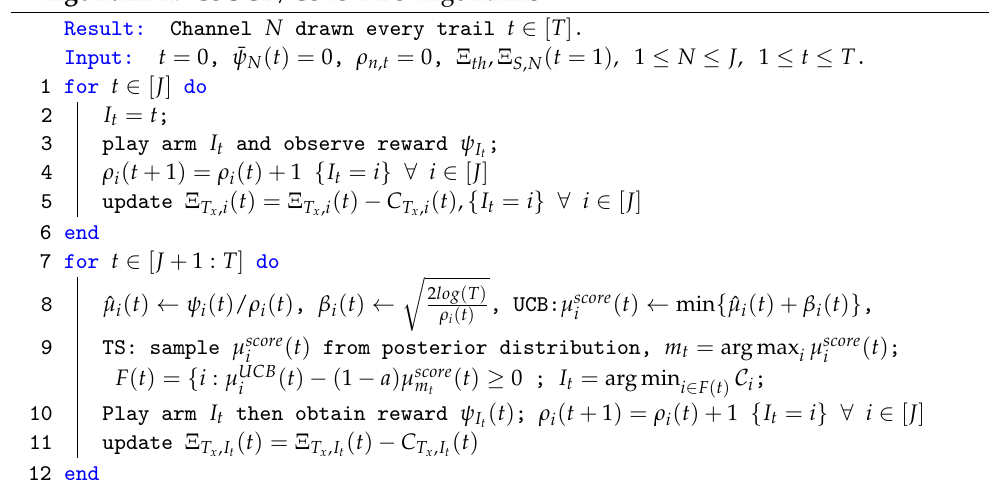
Algorithm 1: CSUCB/CSTS-HBS Algorithms